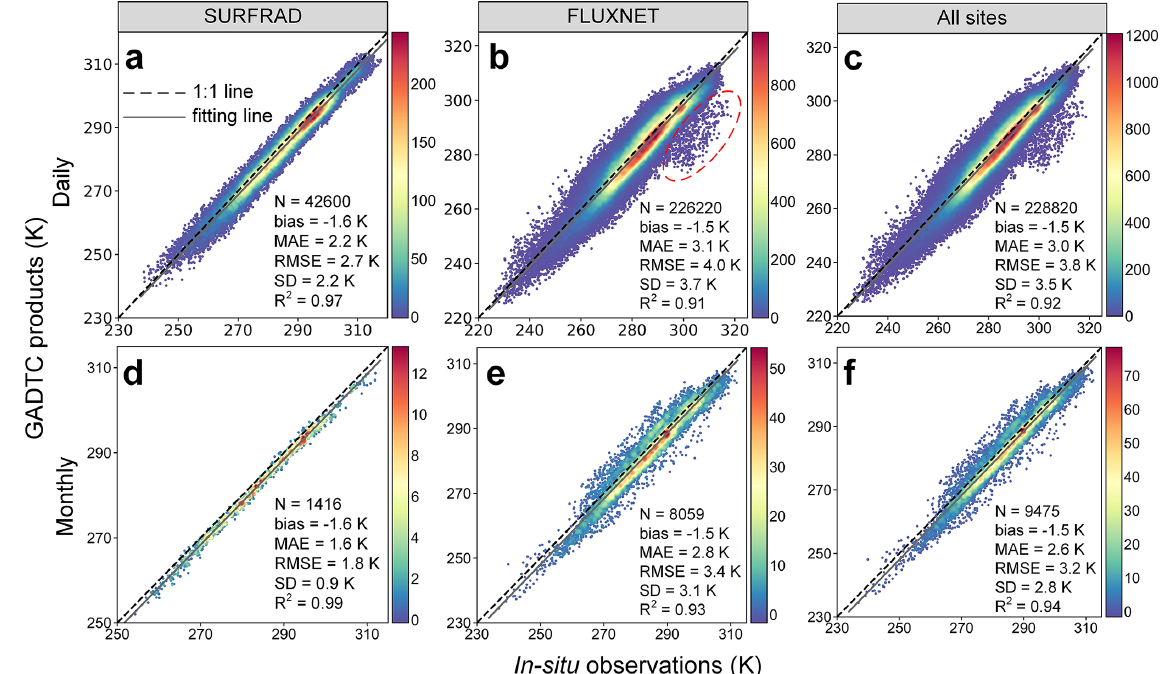
Figure 8. GADTC products versus in situ observations. Panels (a) , (b) , and (c) compare the daily mean LST over the SURFRAD, FLUXNET and combined sites, respectively, and panels (d) , (e) , and (f) show the corresponding results for monthly mean LST. The biases were calculated by the GADTC products minus the in situ measurements. The red ellipse in (b) highlights the cases with notably large errors. Table 1. Validation results obtained over the seven SURFRAD sites. Site ID Lat., long. IGBP N * Bias (K) MAE (K) RMSE (K) SD (K) BON 40.05 ◦ , − 88 . 37 ◦